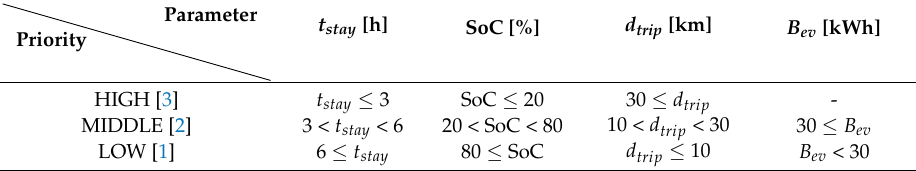
Table 1. Priority definition.